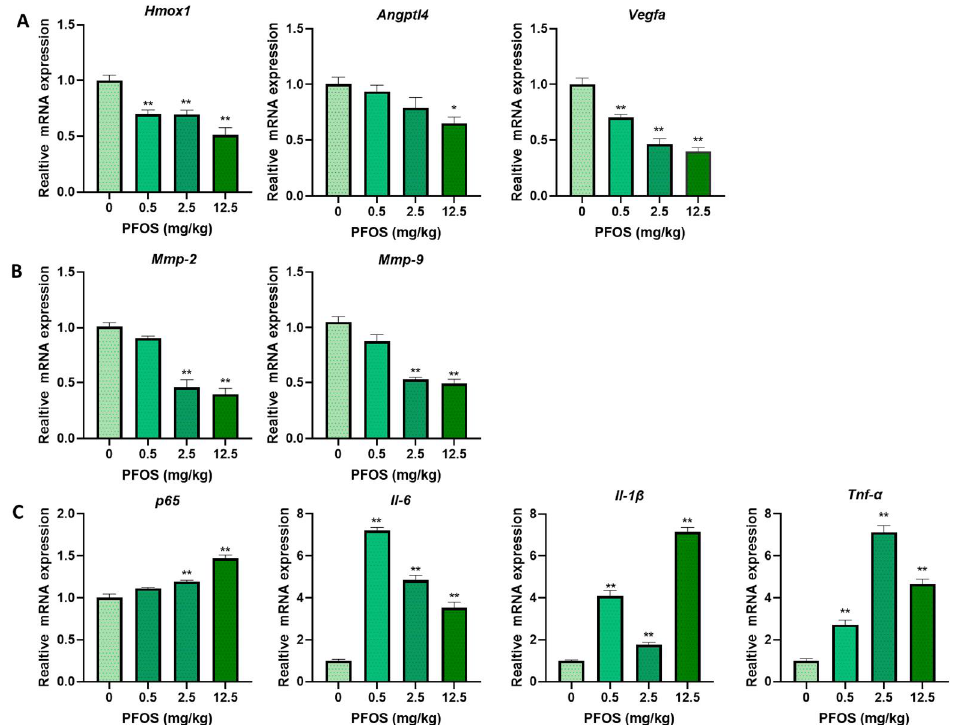
Figure 8. Gestational PFOS exposure alters mRNA level of PPAR γ target genes in mouse placentas. Relative expression levels of PPAR γ target proliferation, angiogenesis ( A ), migration ( B ), and inflammation ( C ) related genes in placentas of mice were analyzed by RT-PCR. The data are shown as the means ± S.E.M. * p < 0.05; ** p < 0.01; compared with control group, n = 3.